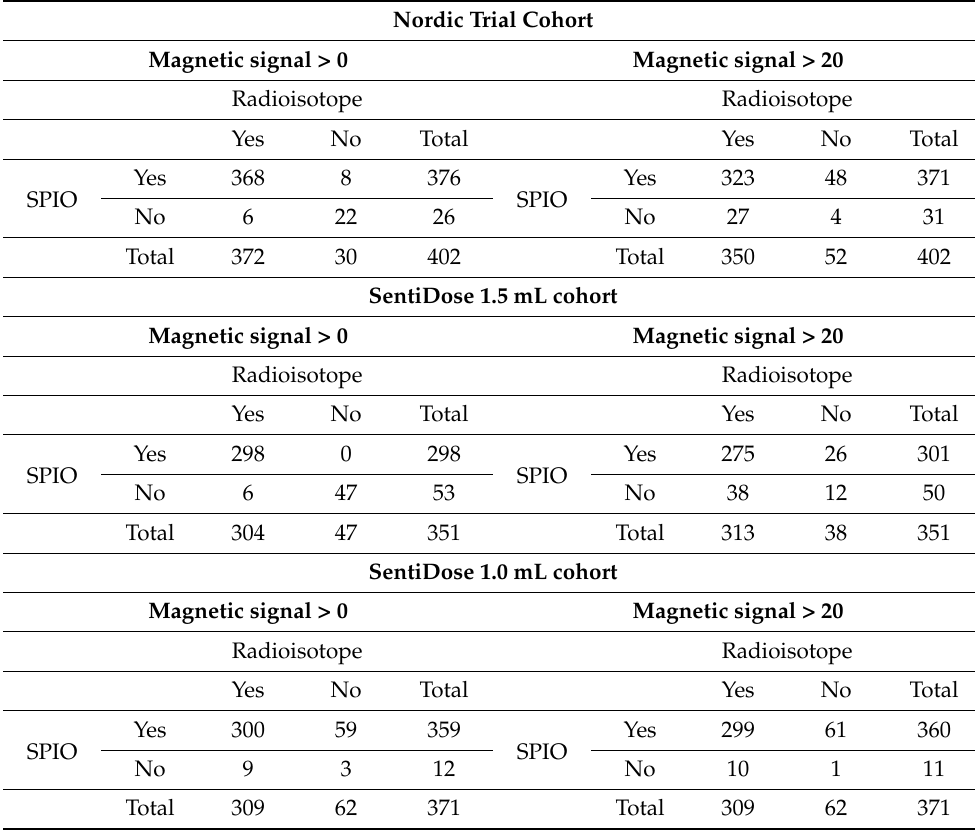
Table 4. Cross-tabulation—Sentinel lymph node detection—in total